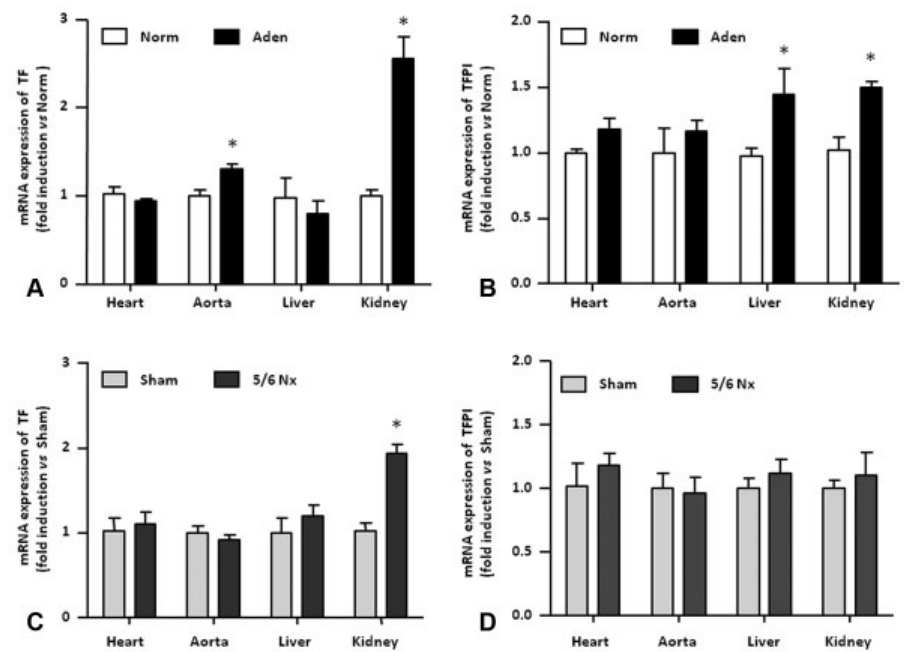
Fig. 3 TFand TFPI mRNA expression in mice with CKD. TF expression ( A, C ) and TFPI expression ( B, D ) were measured in the Heart, the aorta, the liver, and kidneys isolated from CKD mice (Aden and 5/6Nx) and control mice (Norm and Sham). Aden, adenine diet; CKD, chronic kidney disease; mRNA, messenger ribonucleic acid; Norm, normal diet; Nx, nephrectomy; SEM, standard error of the mean TF, tissue factor; TFPI, tissue factor pathway inhibitor. Data are expressed as mean (cid:3) SEM, n ¼ 5/group. (cid:4) p <